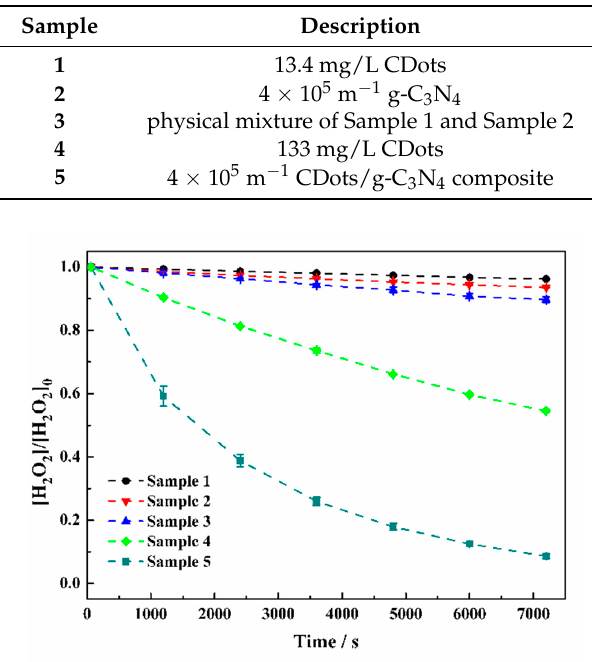
Figure 2. [H 2 O 2 ]/[H 2 O 2 ] 0 ([H 2 O 2 ] 0 = 0.5 mM) as a function of reaction time in the presence of sample 1–5 at 298 K.